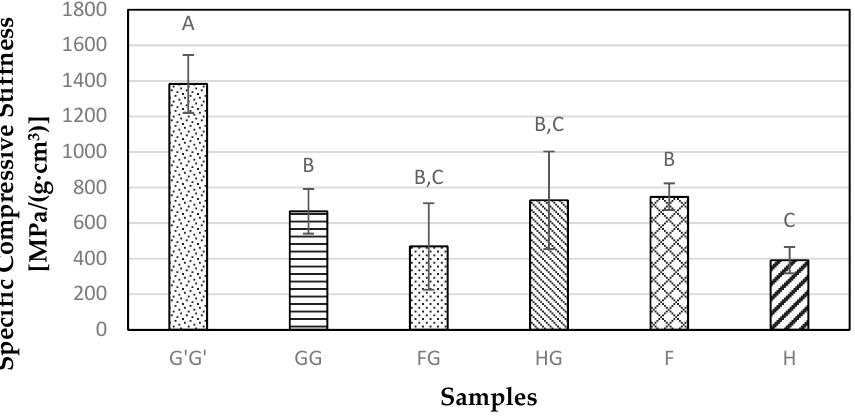
Figure 10. Specific c ompressive stiffness for composite samples containing commercial Glass fiber alone (G’G’), Glass fiber alone (GG), Flax and Glass fiber (FG), Hemp-agave and Glass fibers (HG), Flax fiber alone (F), and Hemp fiber alone (H).